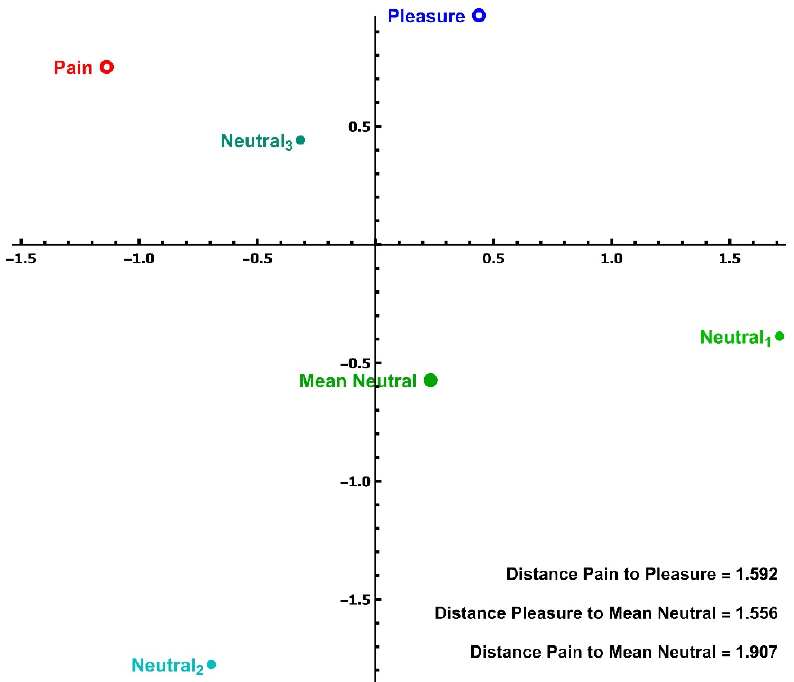
Figure 2. The locations of the dimension-reduced feature vectors of the facial display of the (labeled) affective states of one actress. In addition to these five points, we rendered (and used in subsequent calculations) the arithmetic mean (center of mass) of the neutral states, which we call ‘mean neutral’ for this female. Distances of the dimension-reduced feature vectors for this female are also displayed.